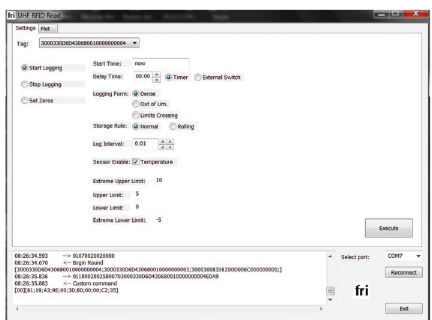
Figure 9: RFID-TL application-Settings.